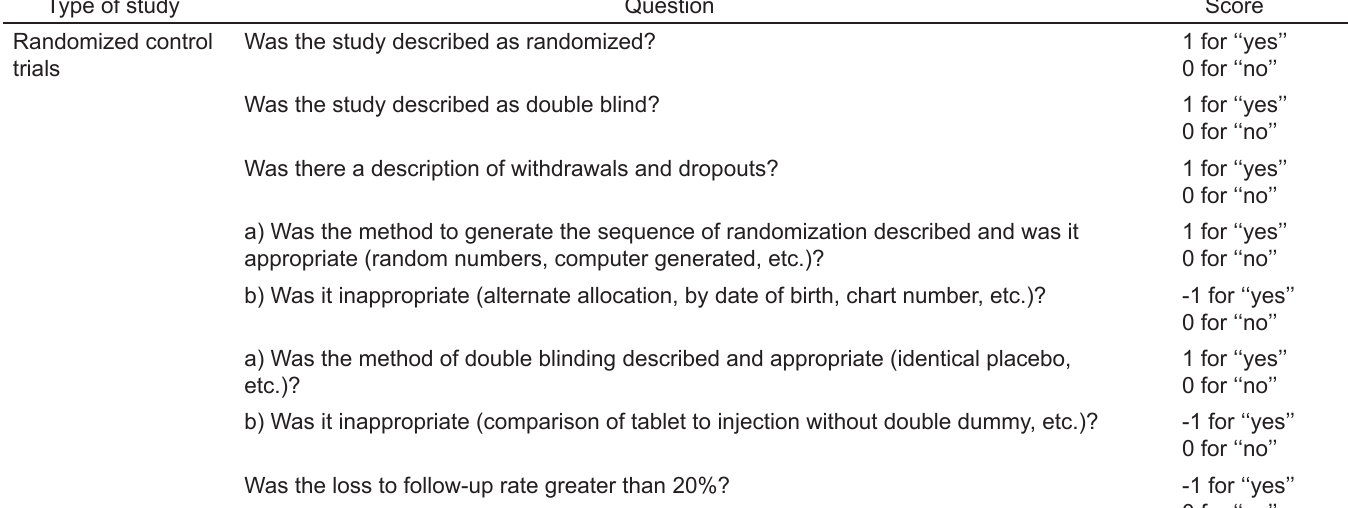
Table. Scoring system used in a survey looking at the effectiveness of brief interventions for suspected alcohol use